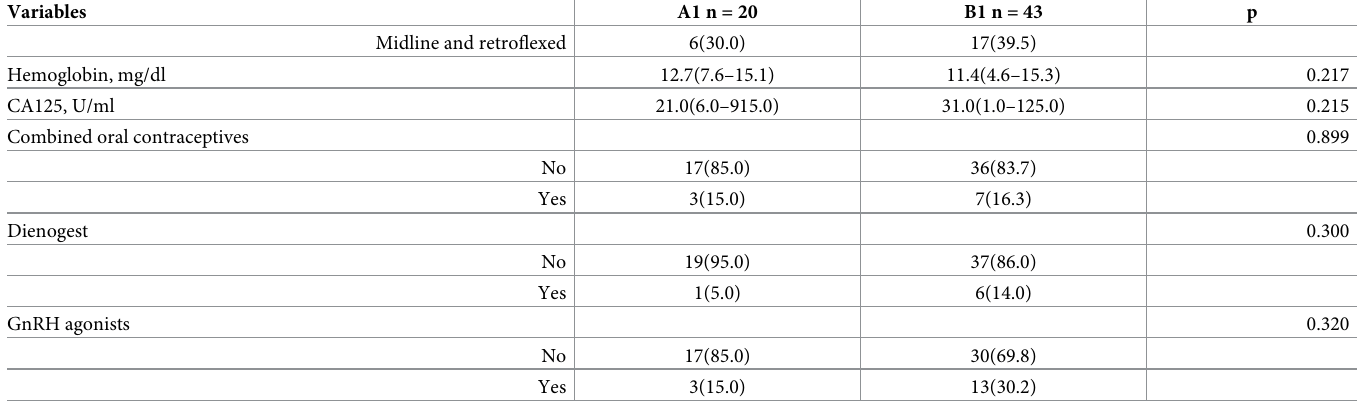
of menarche (P = 0.036), more frequent rectal irritation symptoms (P = 0.038), and smaller uterine volume (P = 0.028), and more elevated preoperative CA125 levels (P = 0.014). Our study showed that there was no significant difference in uterine volume and CA125 levels in patients with early-stage adenomyosis with or without endometriosis (Table 1). Patients with early-stage extrinsic adenomyosis may already have endometriosis, despite small lesions and uterine volume. Furthermore. the B1 phenotype appears to correspond to the focal adenomyo- sis of the outer myometrium (FAOM) reported by Marcellin et al. [24]. The prevalence of FAOM was 56.5% in 255 women with DIE. Our results that endometriosis coexisted in 51.2% of the B1 group are similar to their report. FAOM and type B1 can develop from endometri-